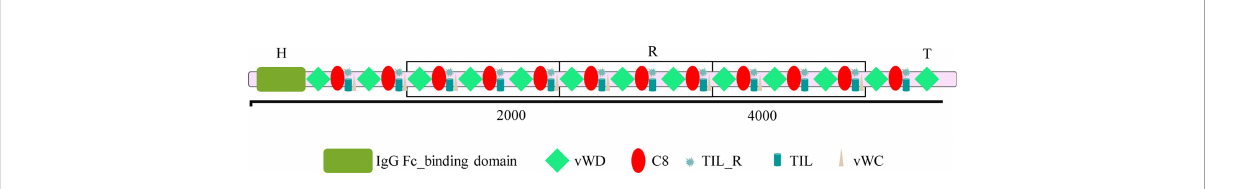
FIGURE 1 The structure of IgGFc-binding protein (FCGBP). vWDs, von Willebrand factor type D domains; C8, contains 8 conserved cysteine residues domains; TIL, trypsin inhibitor – like cysteine-rich domains; TIL-R, reactive site on conserved domain TIL; vWCs, von Willebrand factor type C